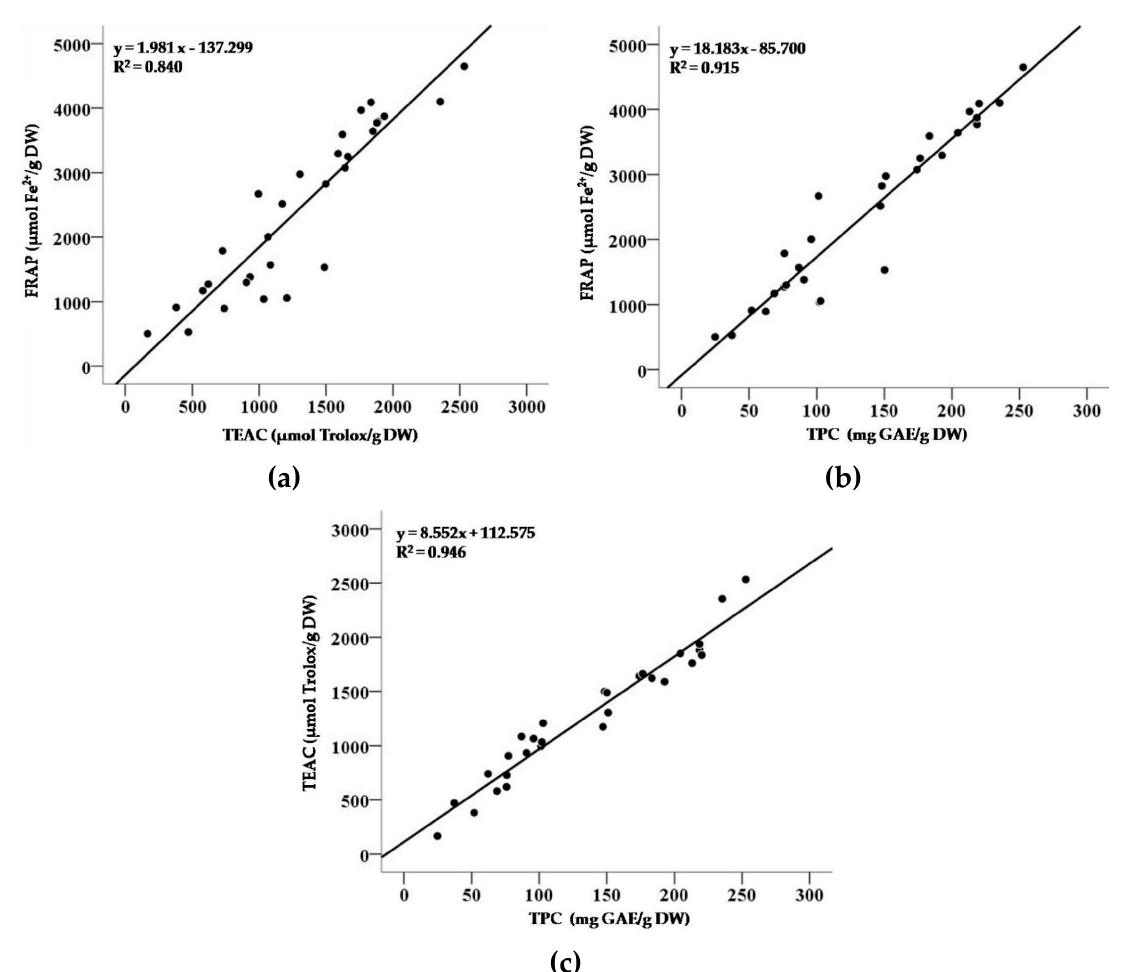
Figure 4. The correlations between values of FRAP and TEAC ( a ), FRAP and TPC ( b ), TEAC and TPC ( c ) of 30 teas.